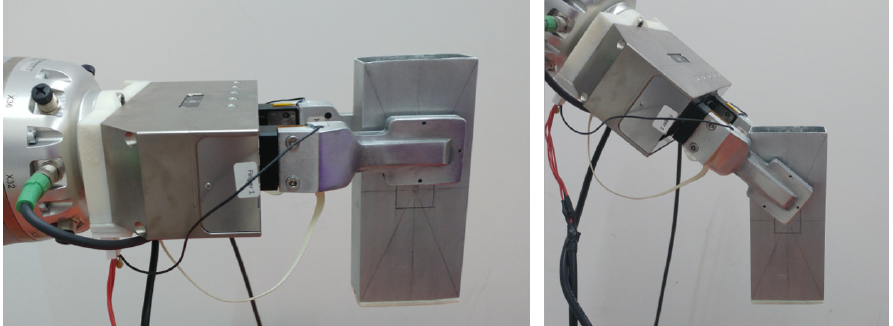
Figure 18. Second experiment: First grasp ( left ) and second grasp ( right ) for the assessment of the tangential force components